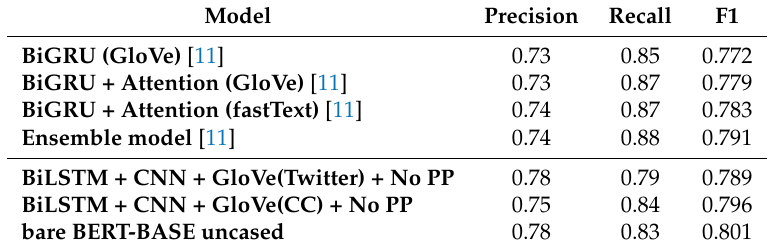
Table 19. Comparison of the performance metrics of the proposed approaches with similar models. Model Precision